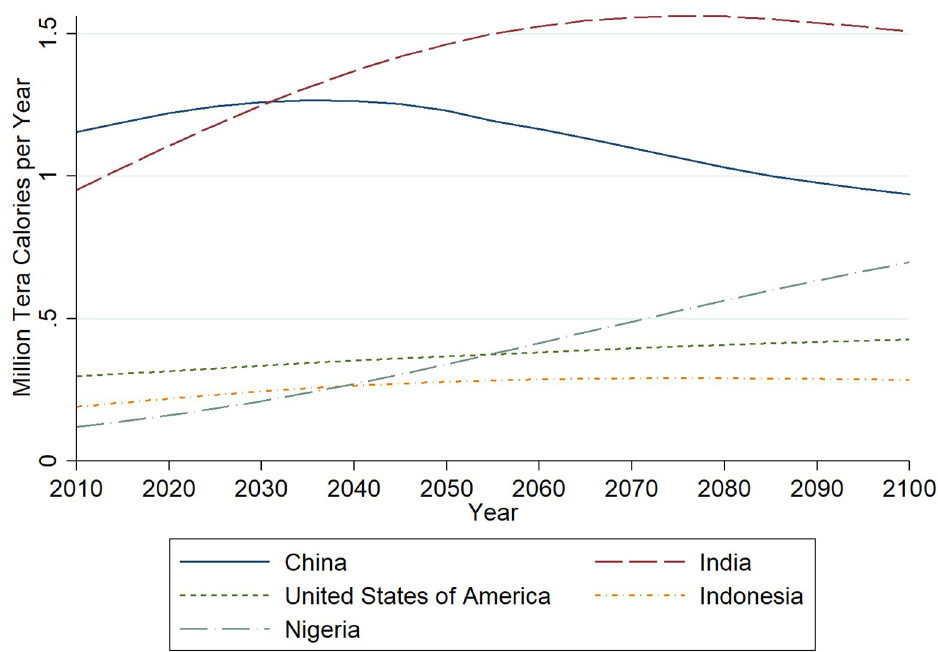
Fig 2. Development of calorie requirements in the four largest countries. As Nigeria joins the group and Indonesia is leaving it, predictions for both are plotted.